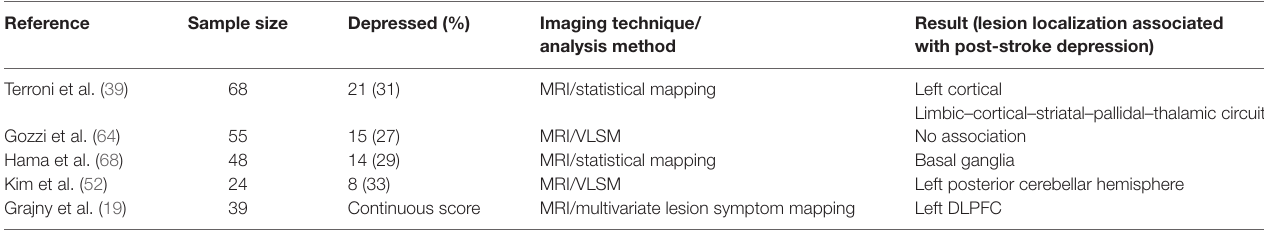
TAbLe 4 | Studies using modern methods of lesion inference